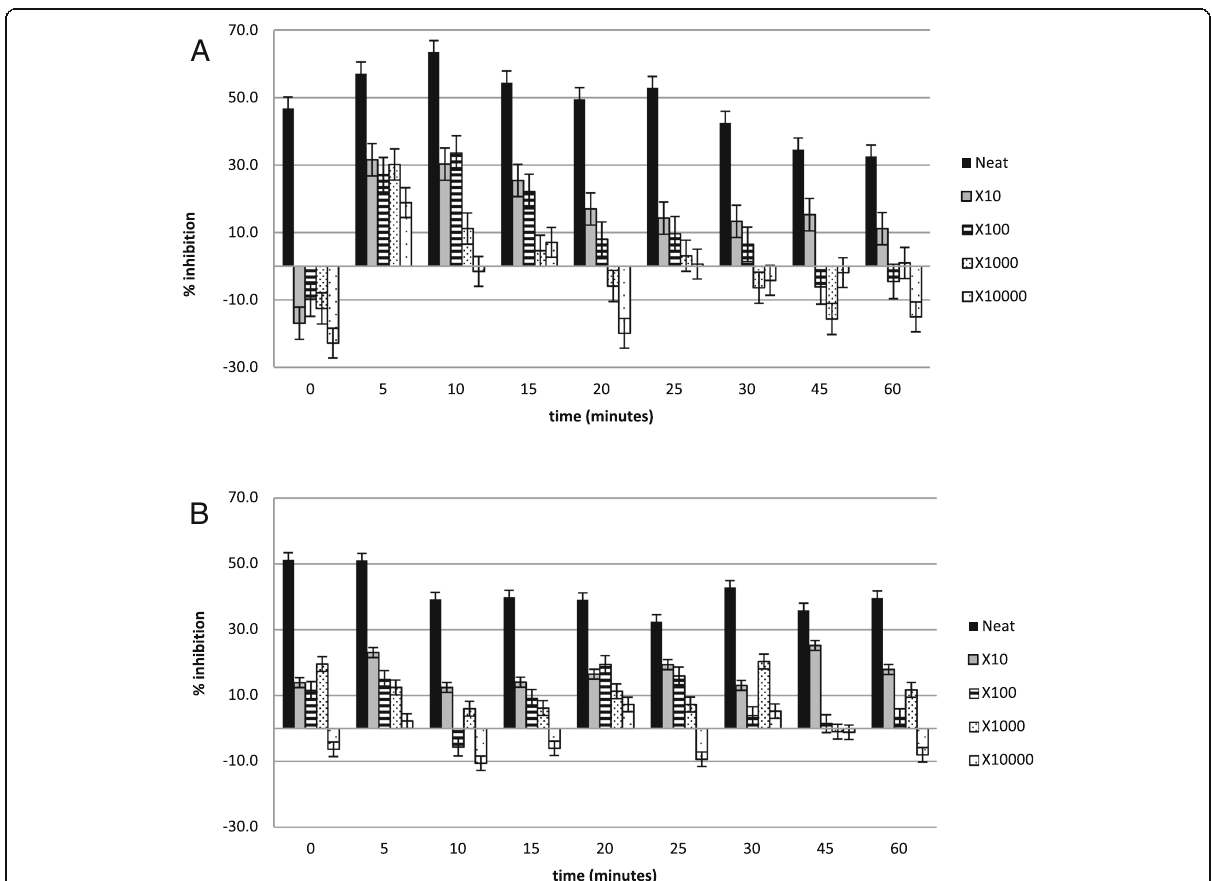
Fig. 4 The % inhibition of healthy platelets after incubation with the HM3 and diluted standards, and activation with ( a ) fMLP and ( b )